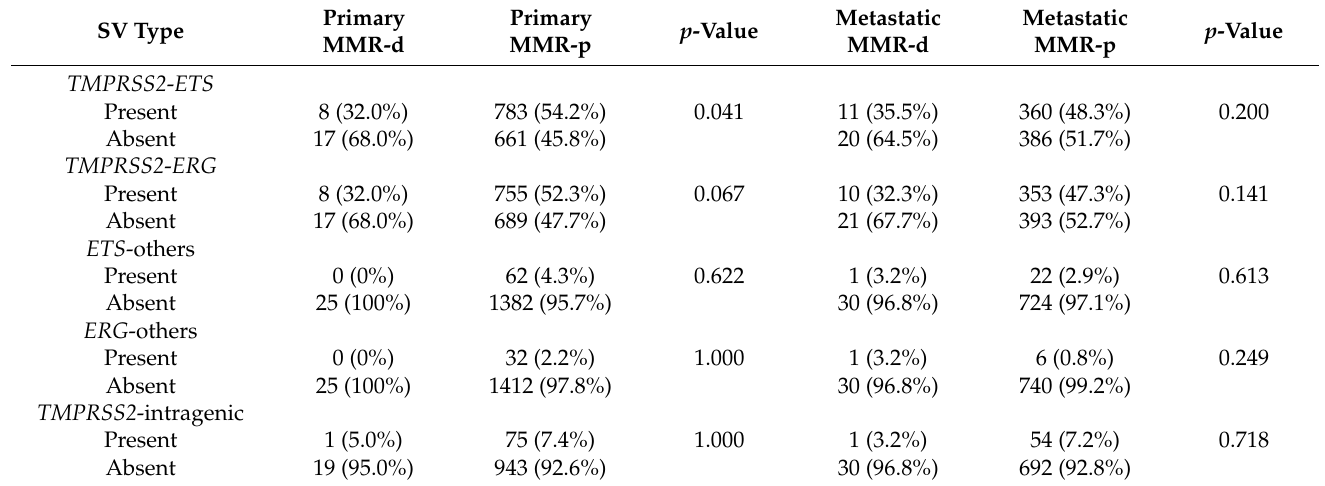
Table 1. Structural variant (SV) frequency by MMR status for primary and metastatic prostate